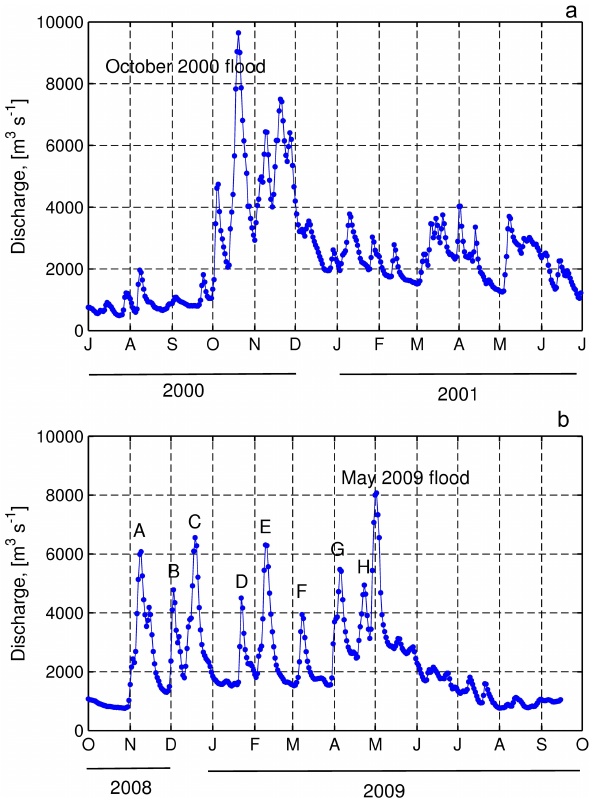
Fig. 2. (a) Po river discharge at Pontelagoscuro station from June 2000 through July 2001. (b) 1-yr Po river discharge at Ponte- lagoscuro station from October 2008 through October 2009.